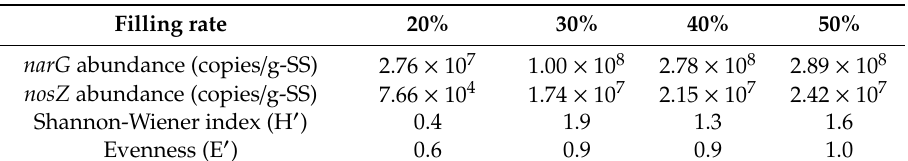
Table 3. Distribution of denitrifying bacteria functional genes and Shannon-Wiener index with evenness at di ff erent FRs.